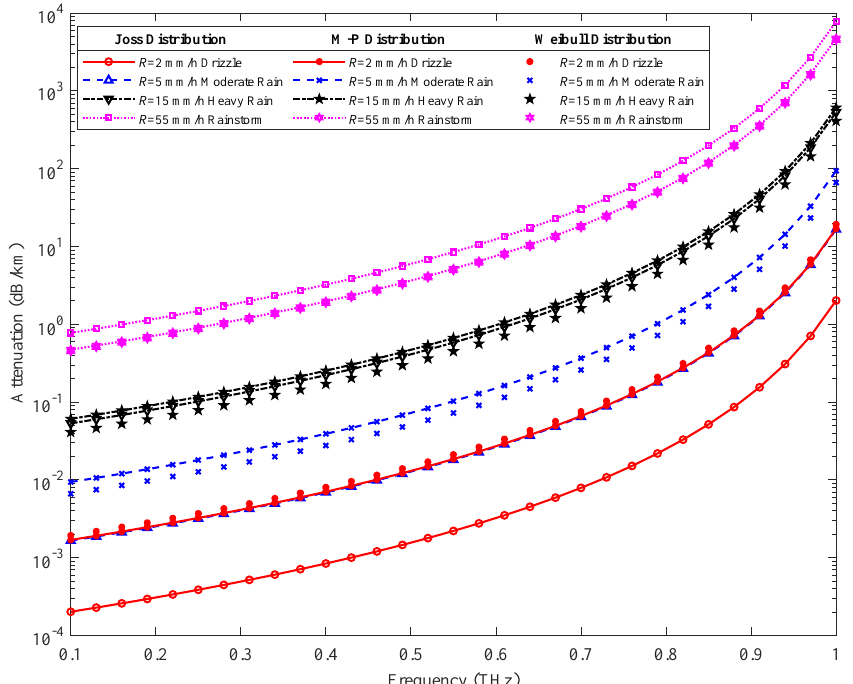
Figure 6. Rain attenuation of THz waves under diverse rainfall rates and